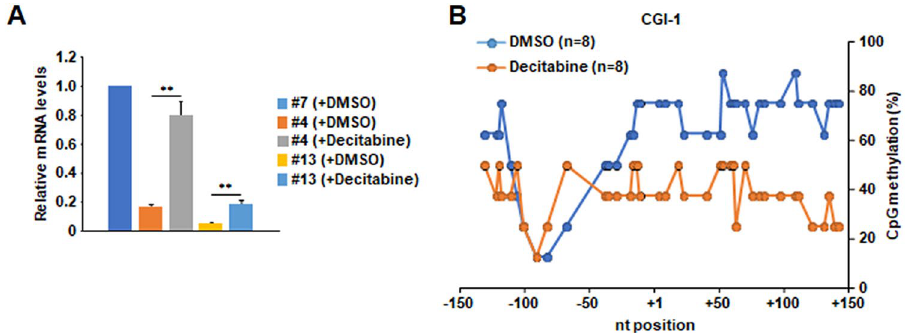
Figure 5. Decitabine-treatment upregulated TERT transcription through the reduction of CpG methylation at CGI-1 of TERT in TAF-I KD cells. ( A ) The expression level of TERT mRNA was examined in decitabine-treated HeLa cell lines. WT clone #7, TAF-I KD clone #4 and clone #13 cells were cultured in medium containing 0.003% DMSO (vehicle) or 30 µM decitabine for 4 days. Total RNA was isolated from each cell, and was subjected to Q-RT-PCR analyses to examine the expression level of TERT mRNA. The 18S rRNA was used for normalization as an internal control. Values represent the mean ± SD (n = 3). ** P < 0.01 relative to each TAF-I KD cells treated with DMSO. ( B ) Bisulfite sequencing analyses. The methylation level of each CpG dinucleotide at CGI-1 of TERT was compared between DMSO or decitabine-treated TAF-I KD clone #4 cells. The